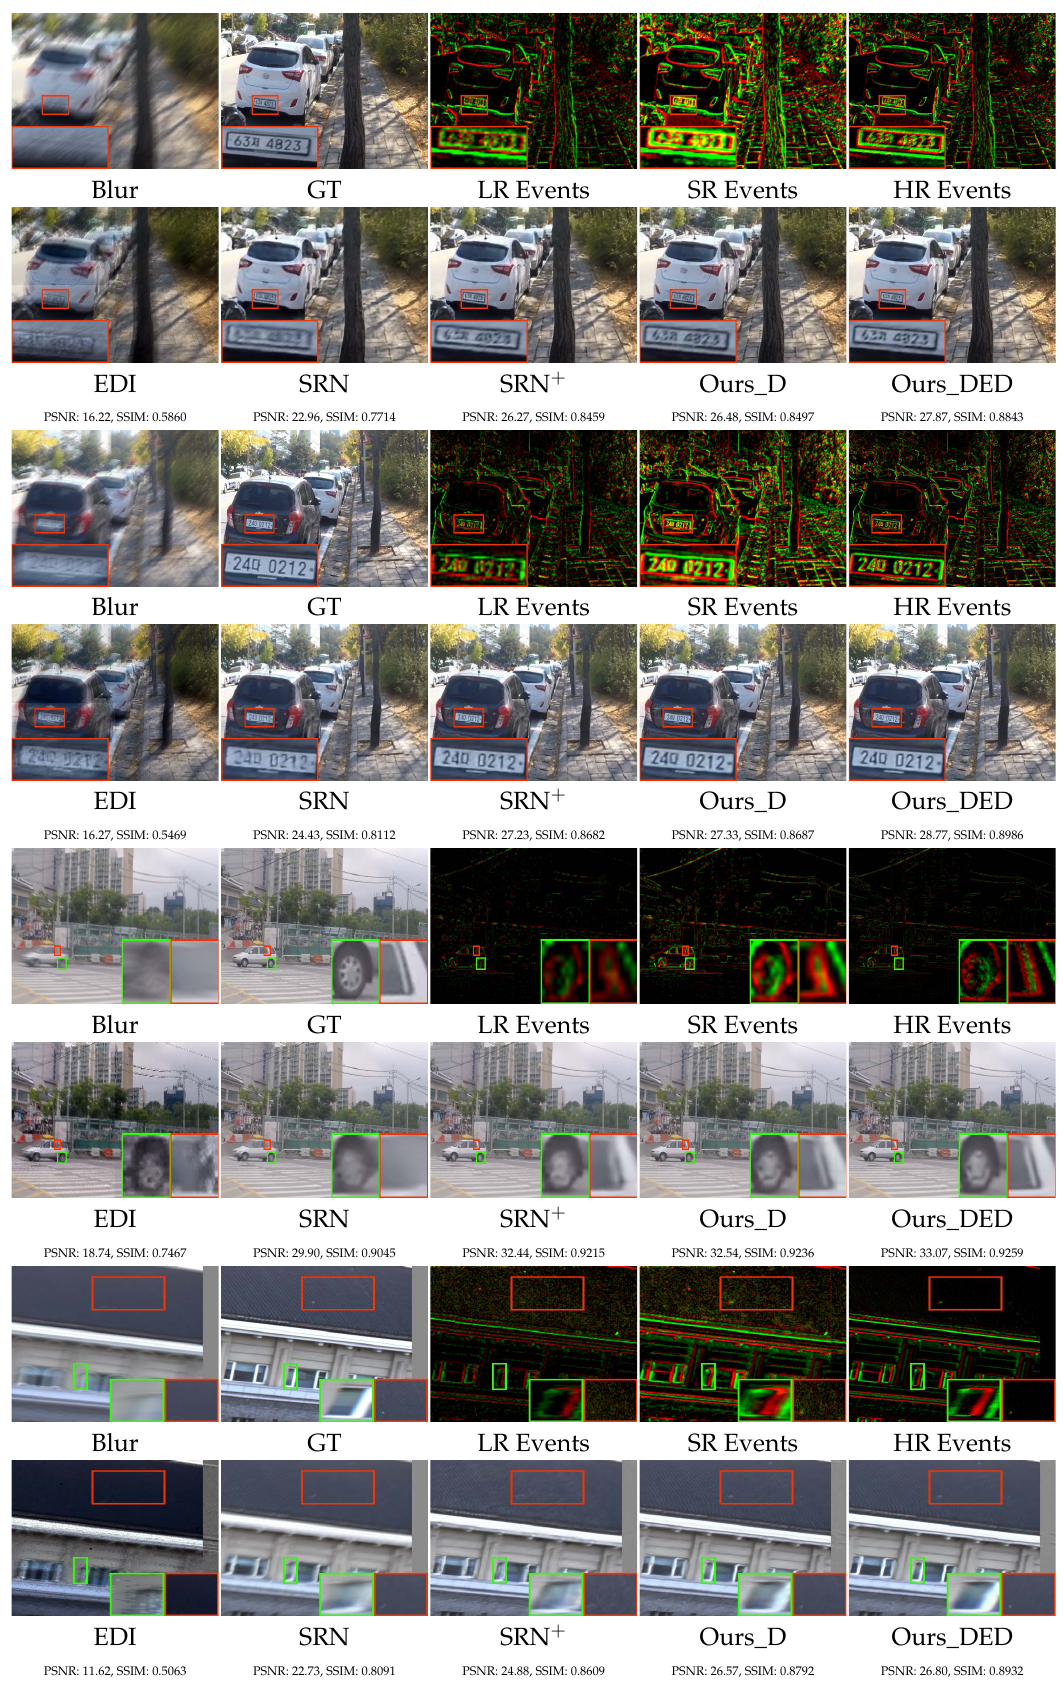
Figure 5. Visual comparisons of image deblurring on × 4 spatial resolution. Obviously,